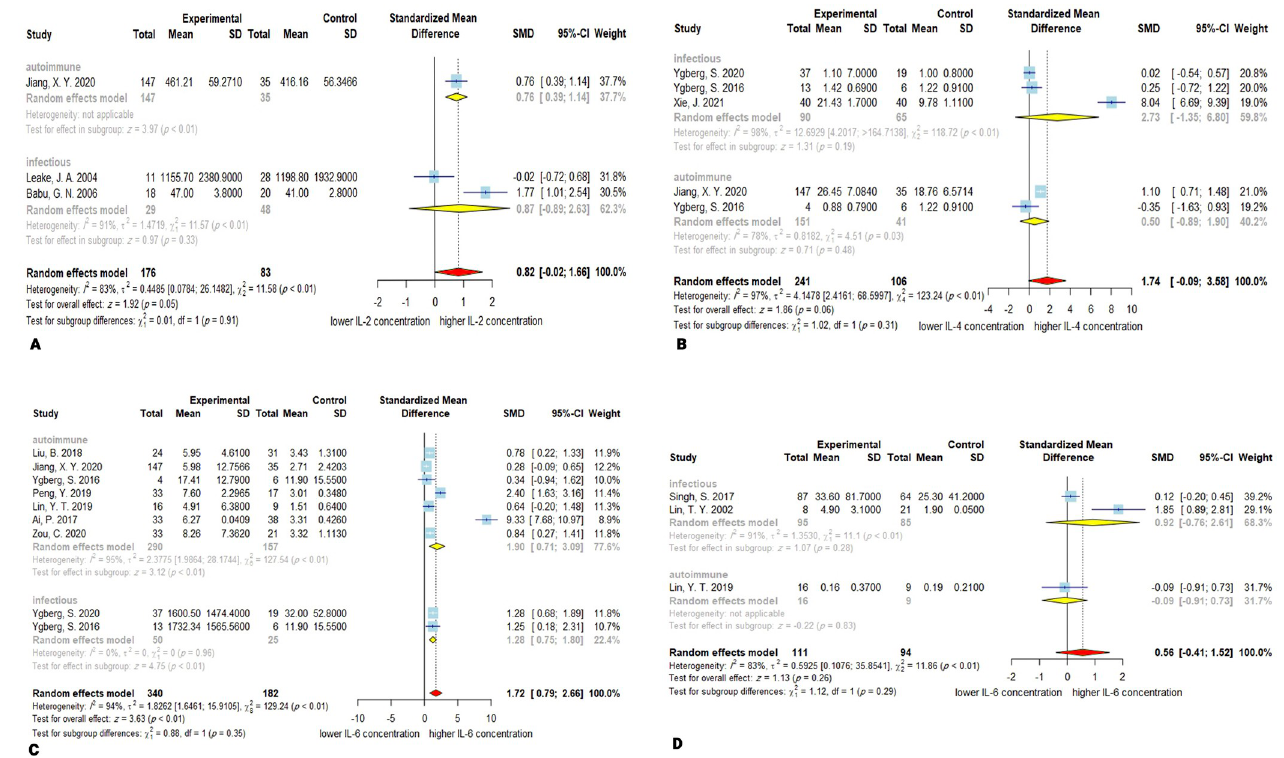
Fig 2. Forest plots for results of meta-analysis for IL-2 CSF concentrations (A) , IL-4 CSF concentrations (B) , IL-6 CSF concentrations (C) , and IL-6 serum/ plasma concentrations (D) . SD, standard deviation; SMD, standardized mean difference; CI, confidence interval.